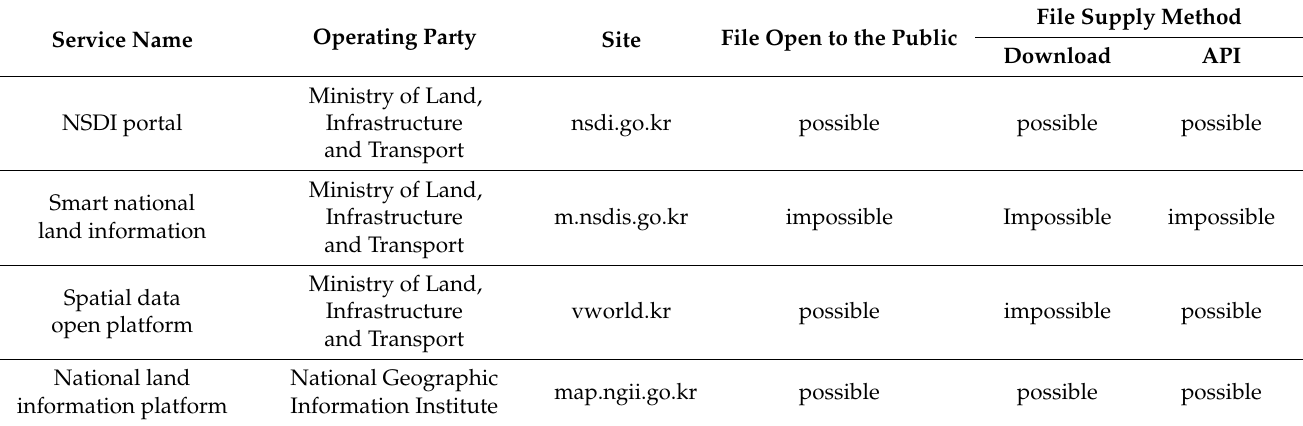
Table 6. Comparison of national spatial data providing services (in terms of data